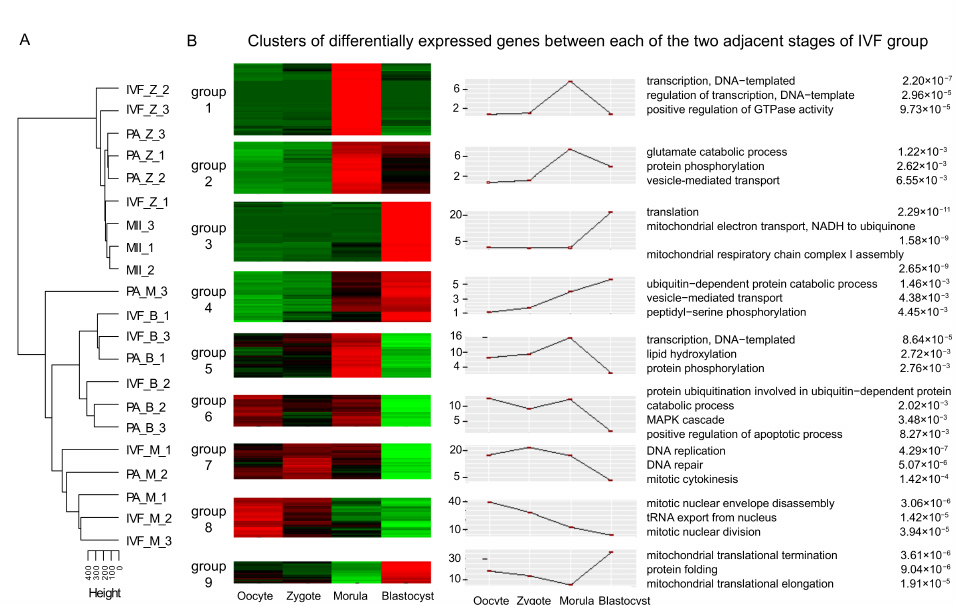
Figure 1. Unsupervised clustering of the expression profiles and differentially expressed genes (DEGs) between adjacent stages of pig embryos in vitro fertilization (IVF). ( A ) Unsupervised hierarchical clustering of the expression profiles; ( B ) Clusters of DEGs between adjacent stages of pig embryos in vitro fertilization (IVF). Gene average log transformed expression values, top GO terms, and corresponding enrichment p -values were